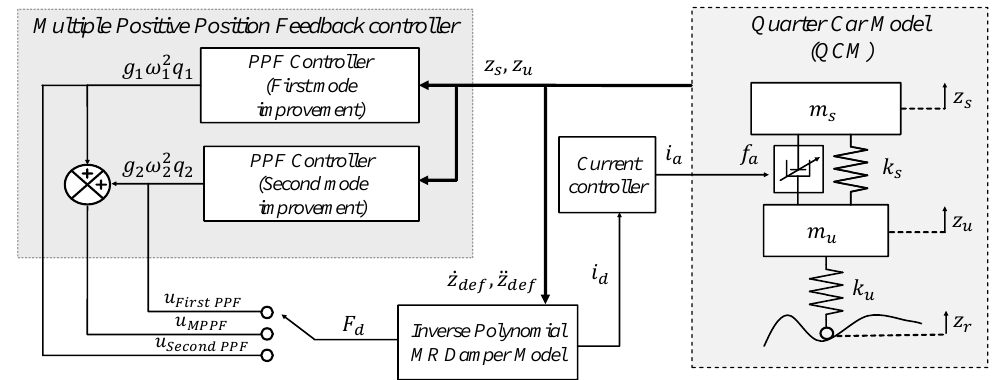
Figure 3. Proposed modal control system for semi-active suspension with magnetorheological damper (MRD) (copyright AMCA (2019), reproduced from